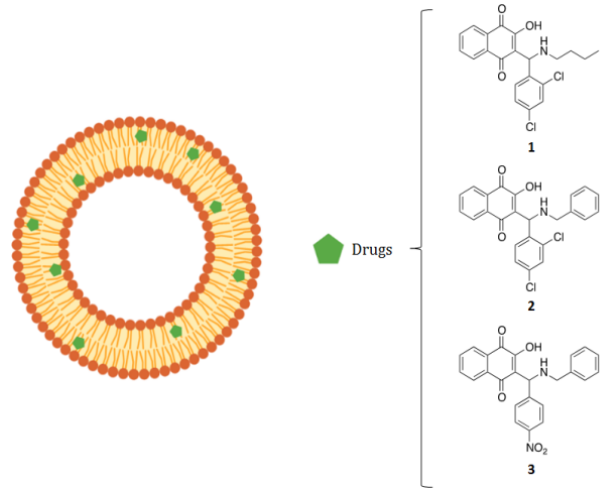
Figure 1. Schematic representation of liposomes loaded with a series of 2-aminomethyl-3 hydroxy 1,4 naphthoquinones derivatives (1 to 3), used in this study to determine anti-HSV activity. Table 1. Size (diameter) and zeta potential measurements of neutral Egg-PC liposomes encapsulating the drugs . Compound